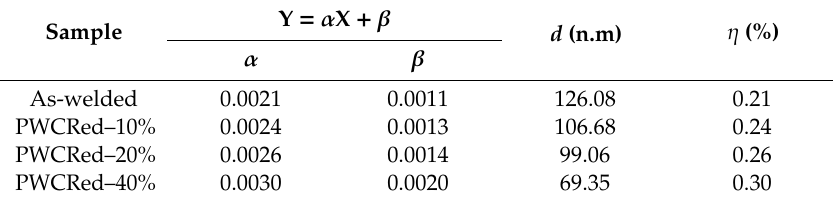
Figure 8. Obtaining crystallite size and strain rolled samples after different reduction based on the Williamson–Hall method. FWHM, full width at the half-maximum intensity. Table 3. Mean crystallite size and strain amount of the rolled sample based on the Williamson–Hall equation.